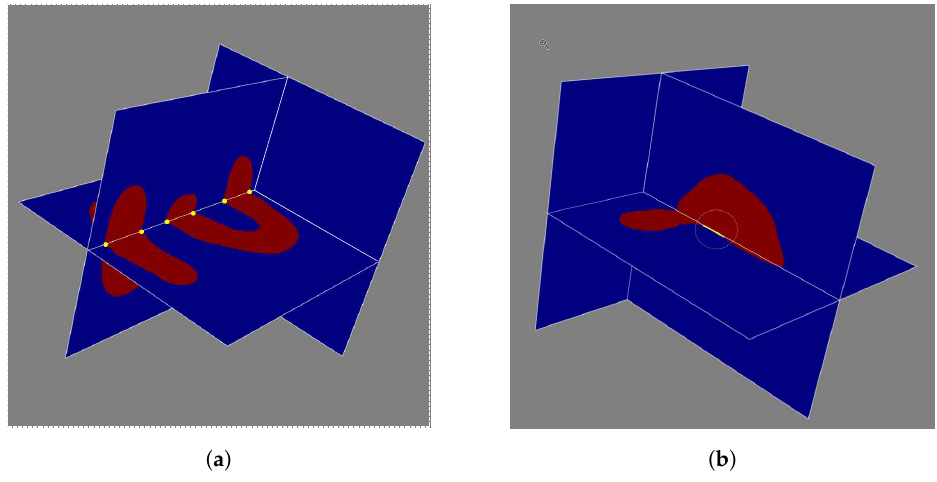
Figure 5. Possible intersection points of annotated non-parallel image slices. ( a ) The intersection occurs in multiple points; ( b ) the intersection occurs in the form of one